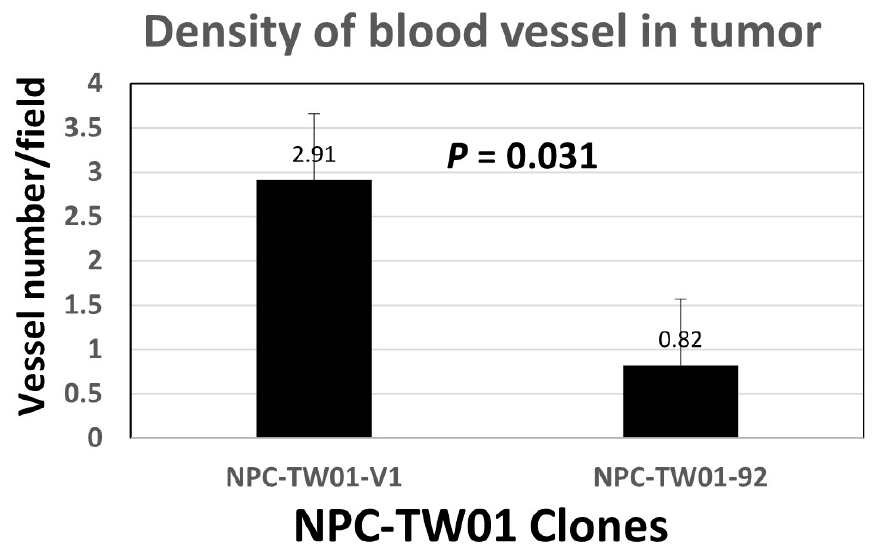
Figure 8. Vascular density in the tumor sections. The vascular density was determined as described in the Section 4.